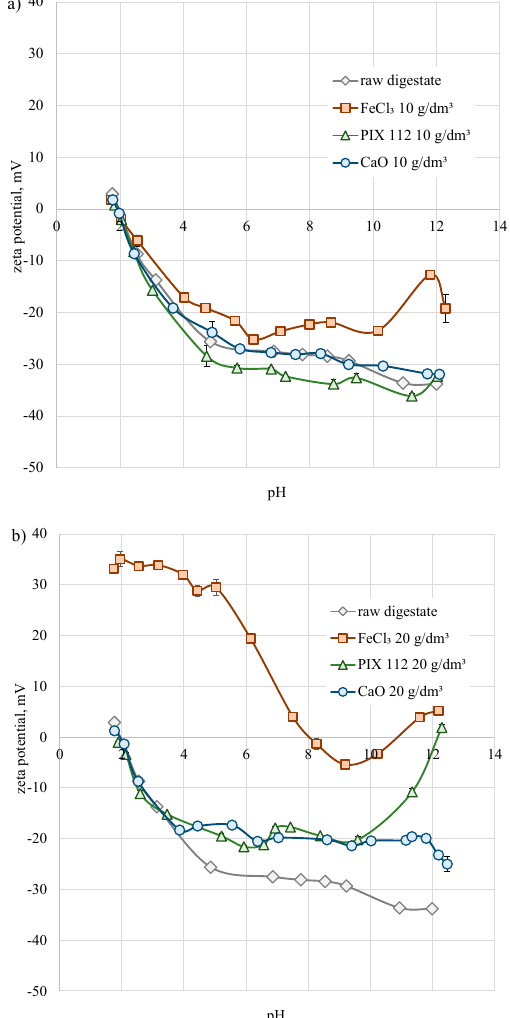
Figure 5. ζ potential of raw digestate and digestate after treatment using FeCl 3 ·6H 2 O, PIX 112 and CaO using ( a ) 10 g/dm 3 and ( b ) 20 g/dm 3 of reagent.